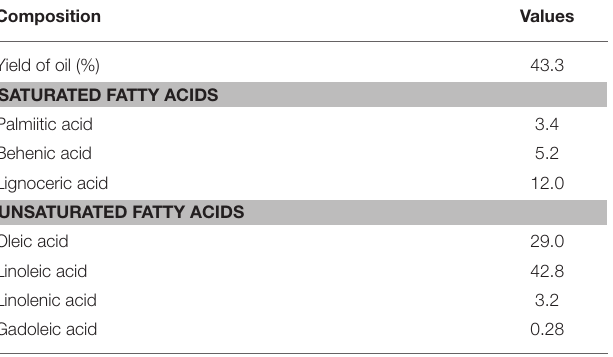
TABLE 3 | Fatty acid composition of African oil bean seeds*. TABLE 4 | Mineral and vitamin content of unfermented and fermented